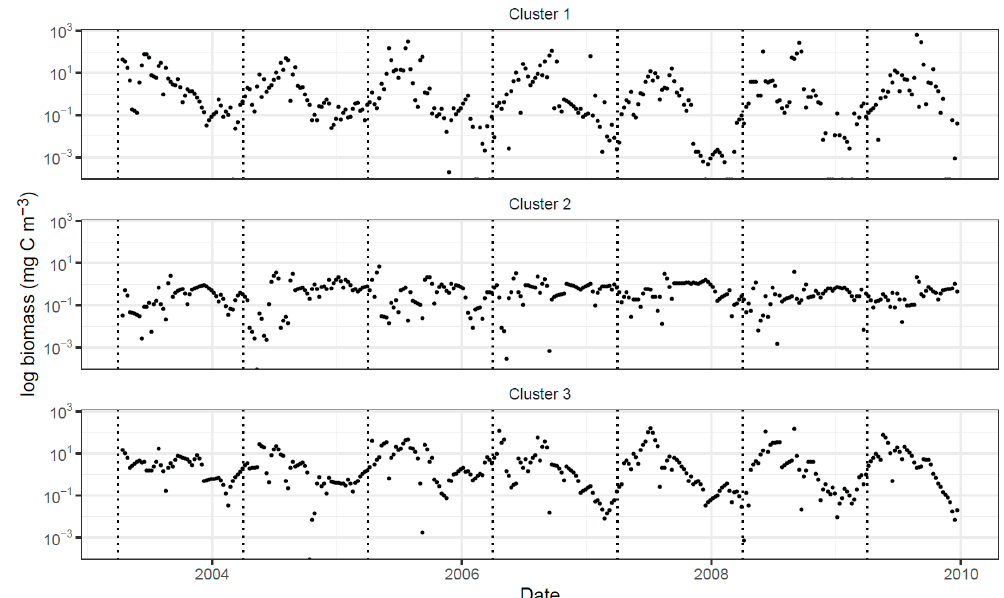
Figure 3. Time plots of log-biomass for Cluster 1 (top), Cluster 2 (middle), and Cluster 3 (bottom) over the study period. Dashed vertical lines mark April 1 each year to highlight differences in seasonality between clusters 1 and 3.